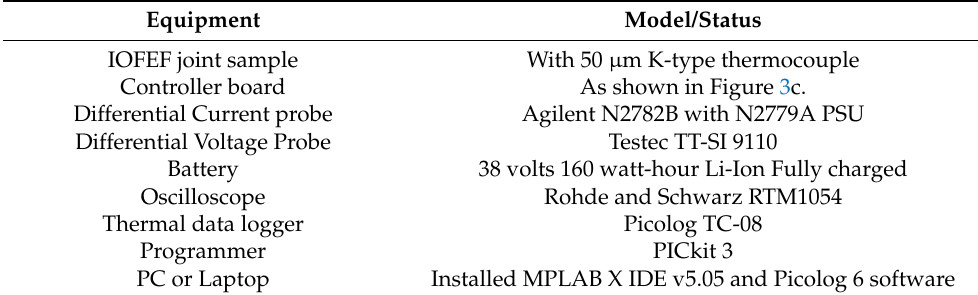
Table 2. Equipment and software required for the validation experiment.